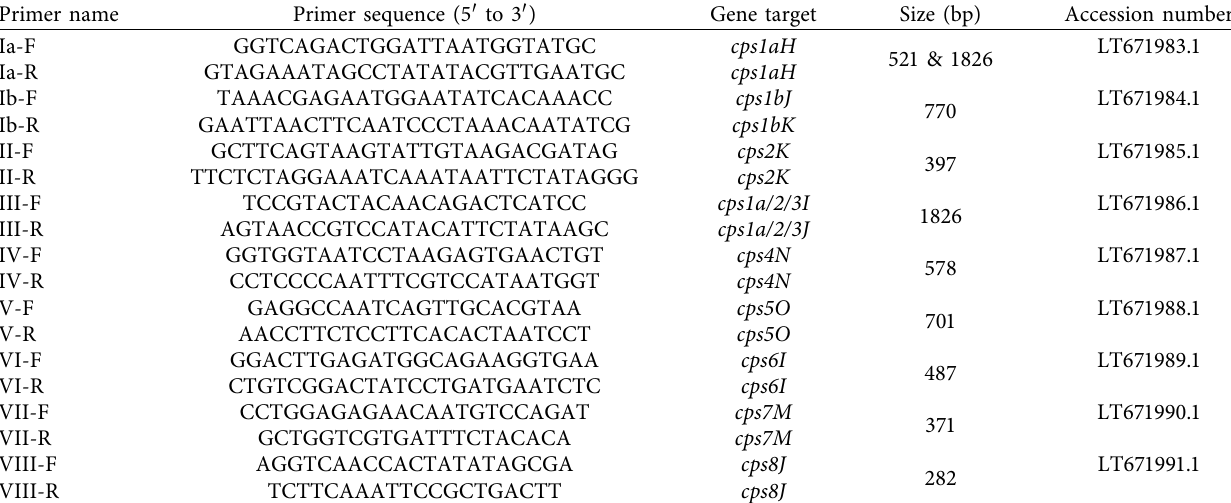
Table 1: Primer sequences and the gene targets used in the study.